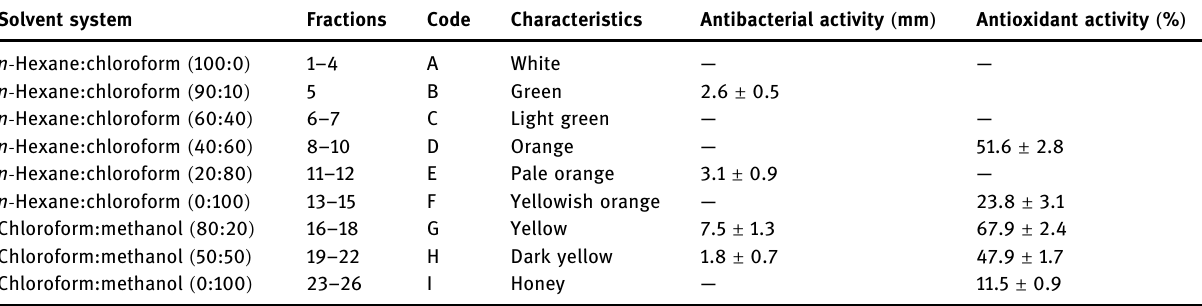
Table 3: Antibacterial and antioxidant activities of various fractions separated from AE of R. mucronata Solvent